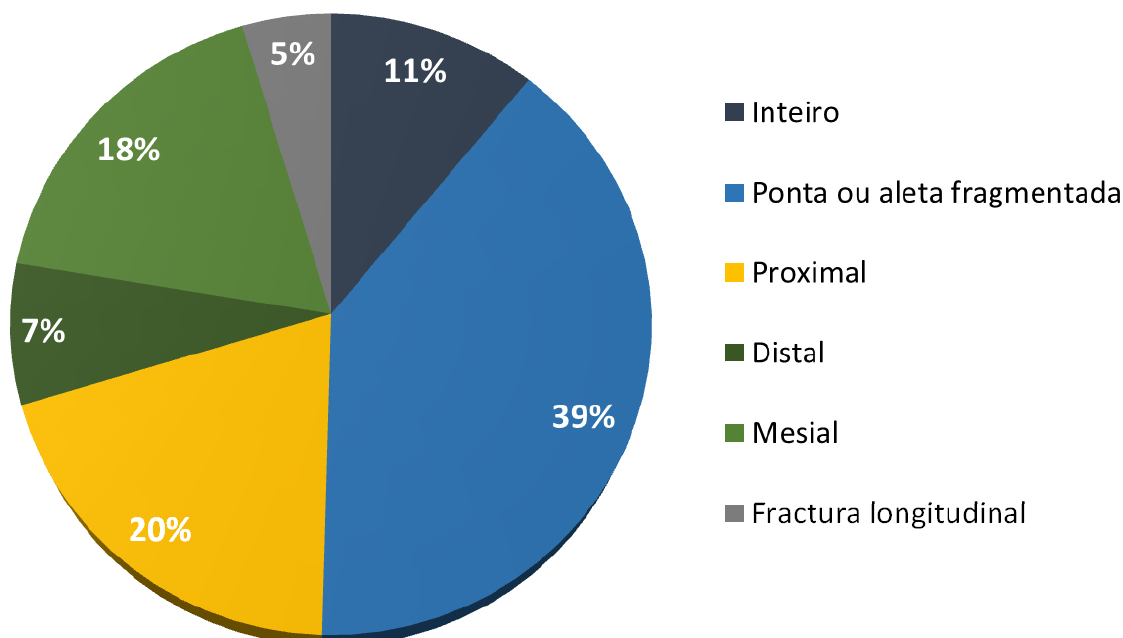
Figura 2. Estado de conservação das pontas de seta do Zambujal: inteiro; ponta ou aleta fragmentada; proximal; distal; mesial e fractura longitudinal. Figure 2. Zambujal arrow points conservation status: complete, broken tip or wing; proximal; distal; middle and longitudinal